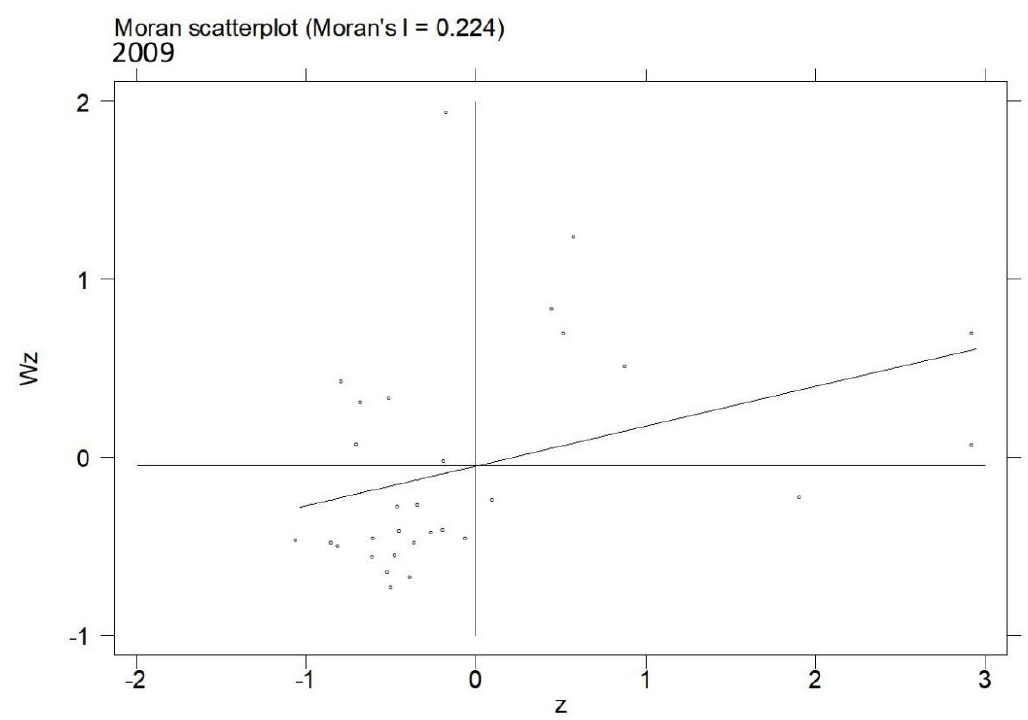
Figure 3. The Moran scatterplot maps of WRGUE in 30 provincial administrative units in 2009.